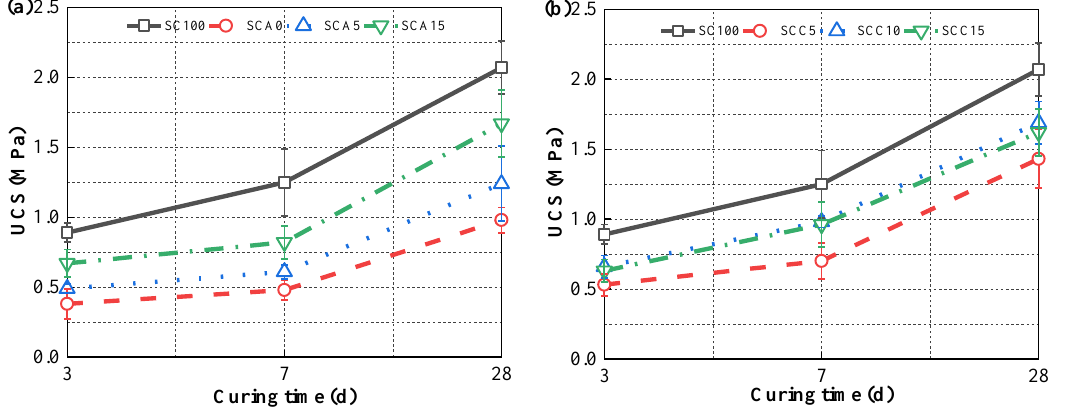
Figure 5. Unconfined compressive strength (UCS) variation of hardened CPB with different doses of ( a ) C Ṡ A and ( b ) quicklime.